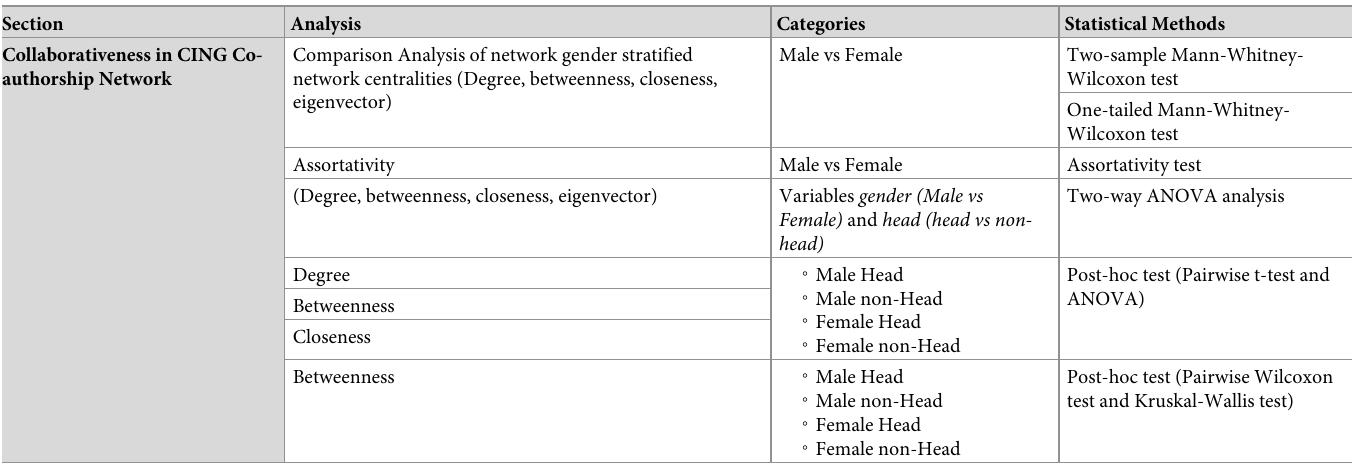
Table 2. Methods for collaborativeness in CING co-authorship network